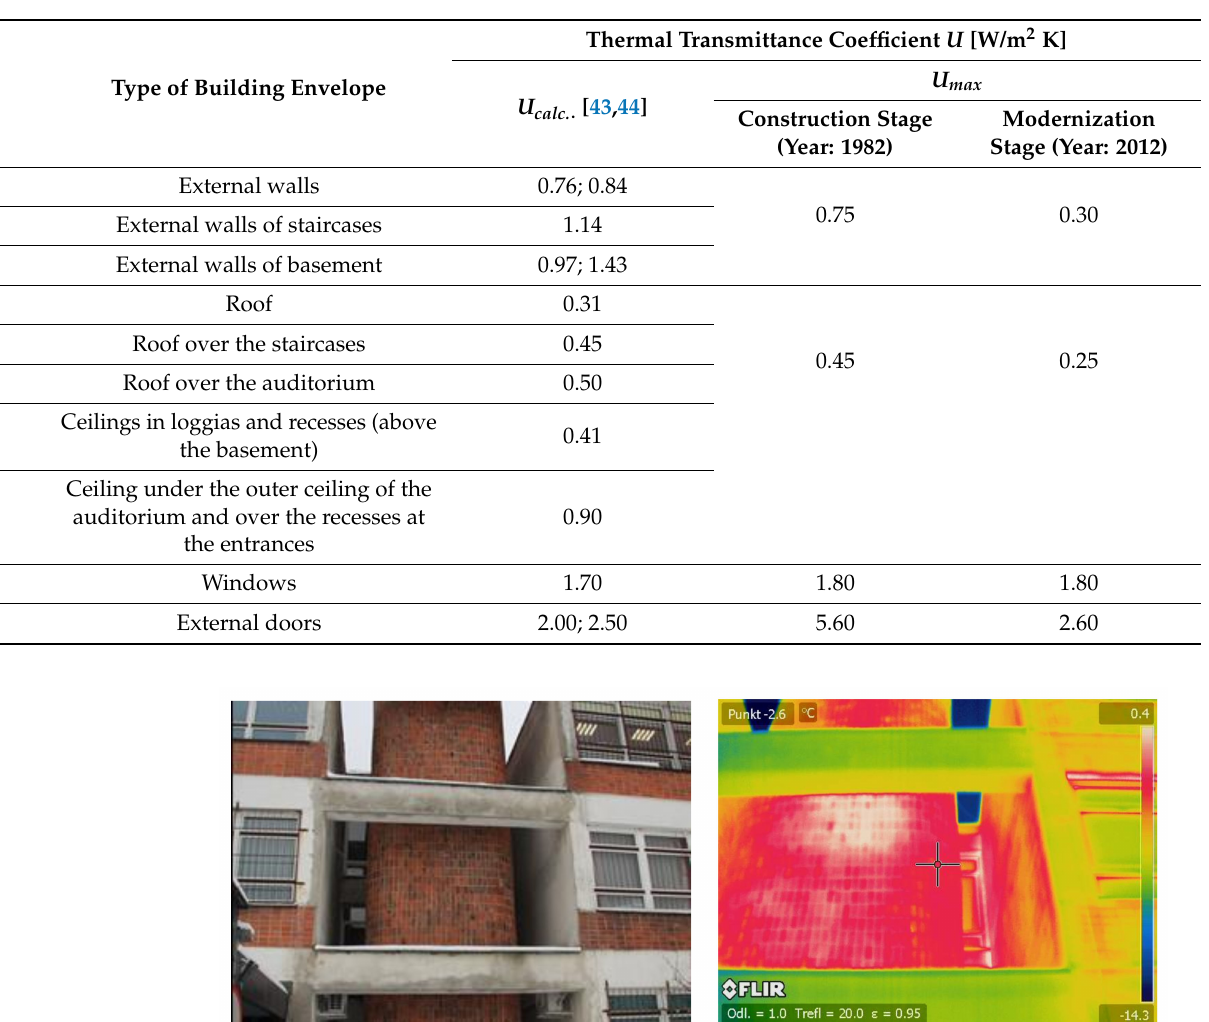
Table 3. Thermal characteristics of the partitions of the analyzed building along with the applicable requirements in Poland during the construction and modernization of the building [9,43].